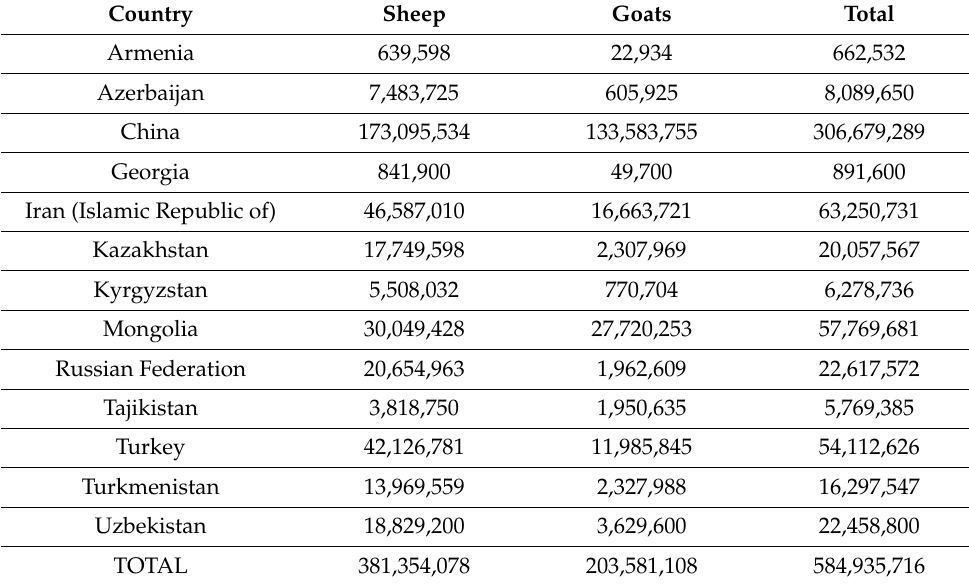
Table 1. Sheep and goat populations at regional and national levels, according to latest available figures (2020) in FAOSTAT. Country Sheep Goats